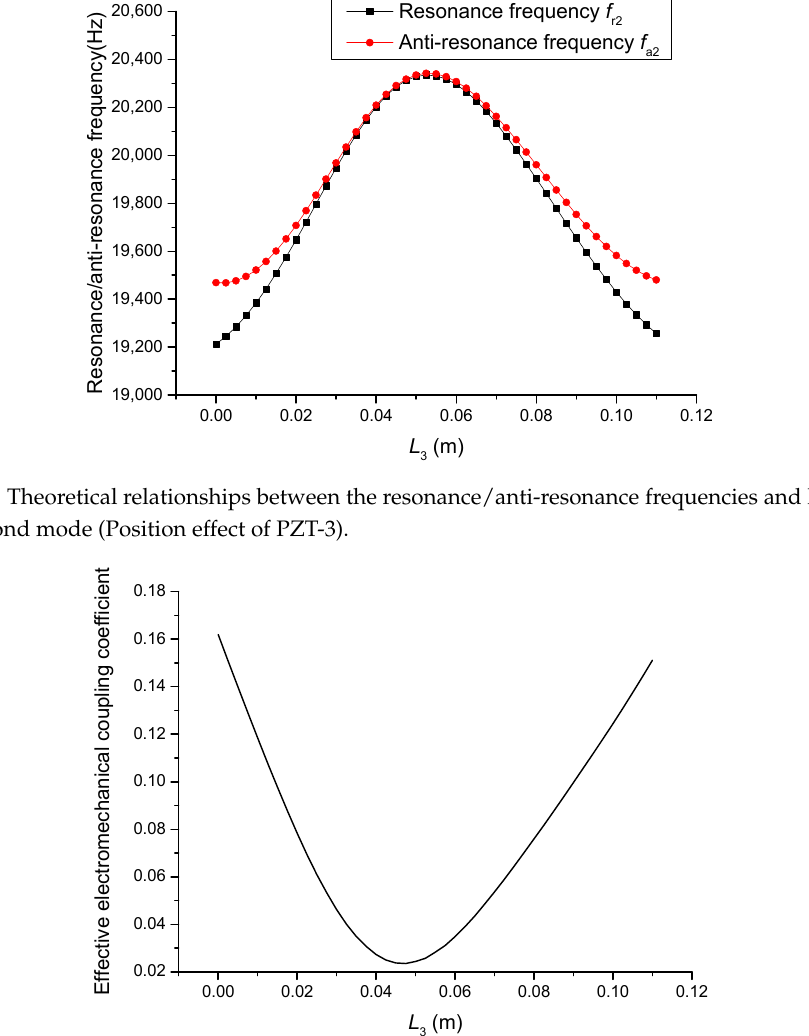
Figure 14. Theoretical relationship between the effective electromechanical coupling coefficient and length L 3 at the second mode (Position effect of PZT-3).